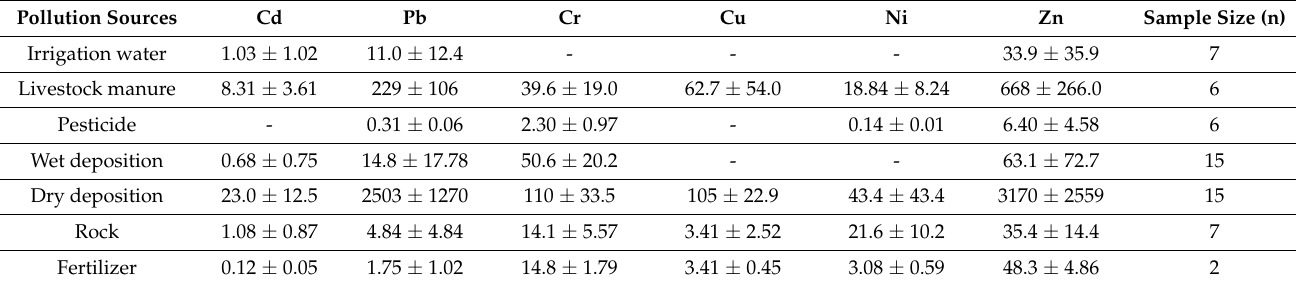
Table 3. Concentration of heavy metals in potential sources (mg · kg − 1 ).